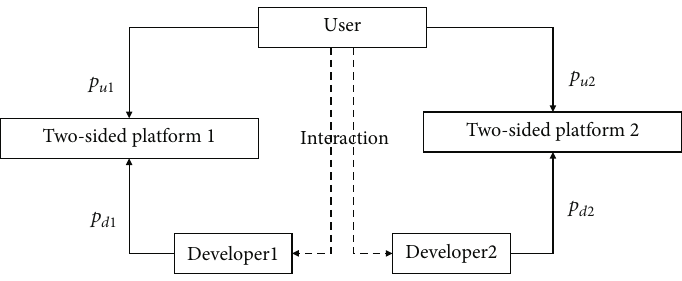
Figure 1: Two-sided market